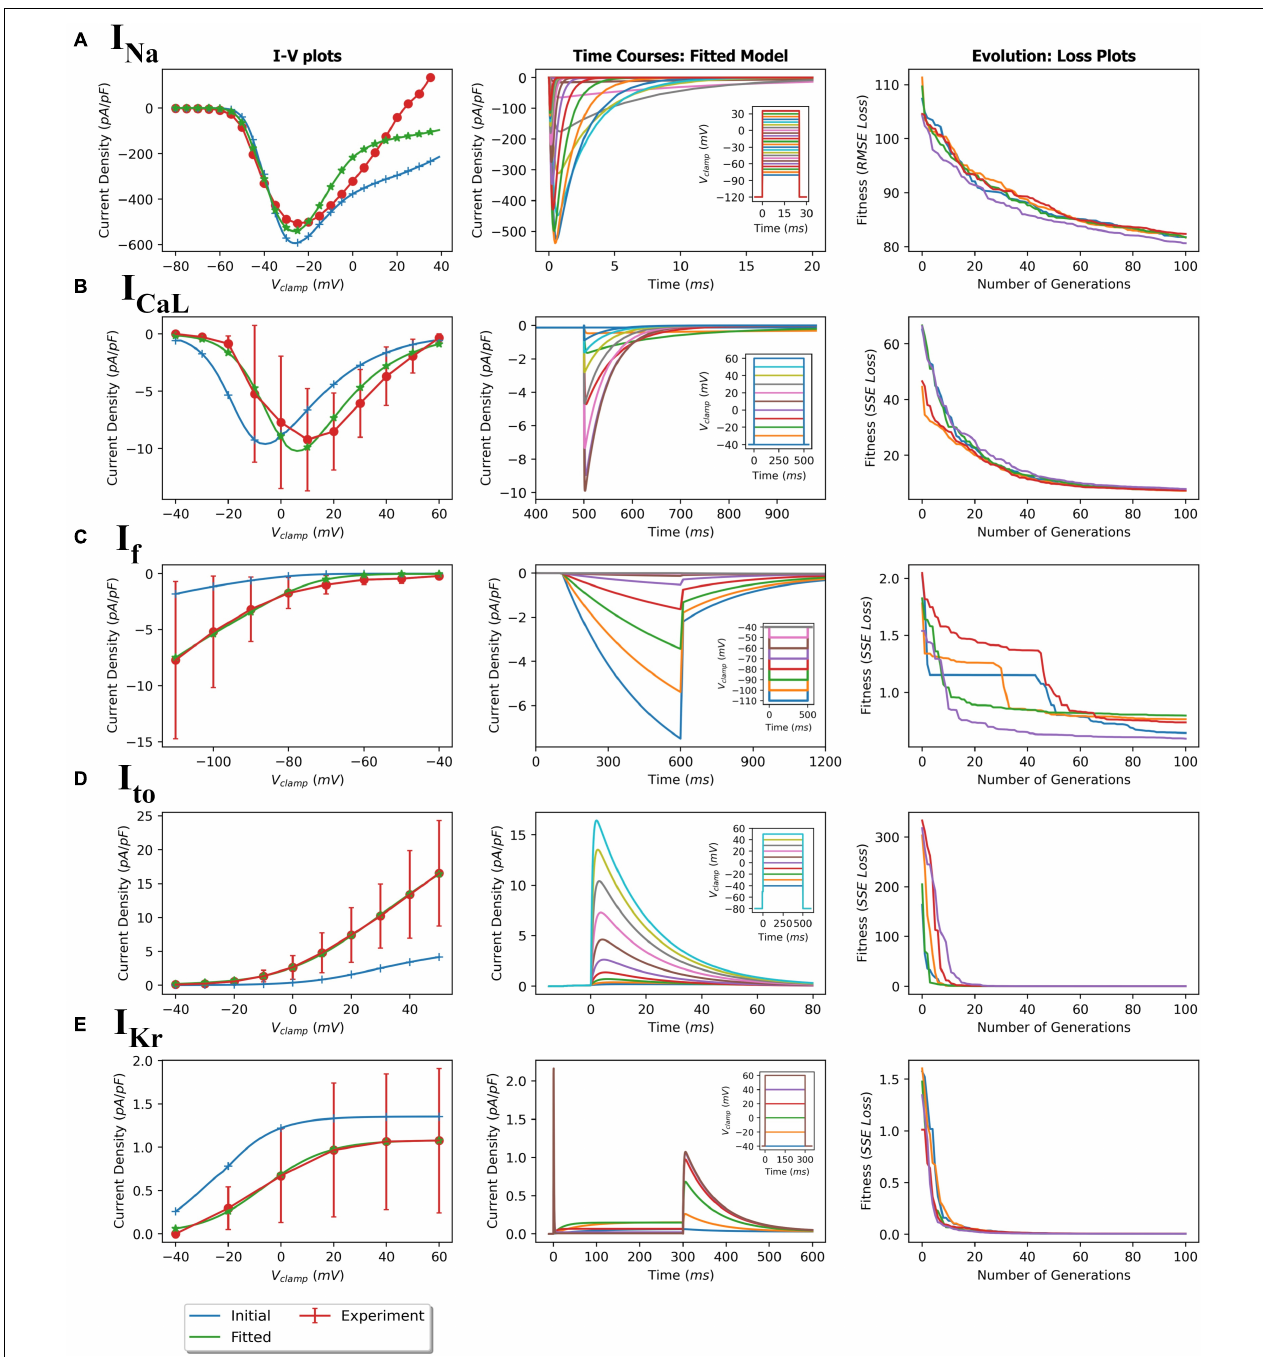
FIGURE 4 | GA-based parameter fitting of ionic currents. (A) fast sodium current ( I Na ); (B) L-type calcium current ( I CaL ); (C) Hyperpolarization-activated current ( I f ); (D) transient outward potassium current ( I to ); and (E) delayed rectifier potassium current ( I Kr ). The left plots show initial and final fitted I-V plots for each current compared with the corresponding experimental values. Middle plots show the simulated time course of current activations based on the corresponding voltage clamp protocols (insets). Right plots show loss (RMSE or SSE) over 100 generations showing convergence during the GA fitting